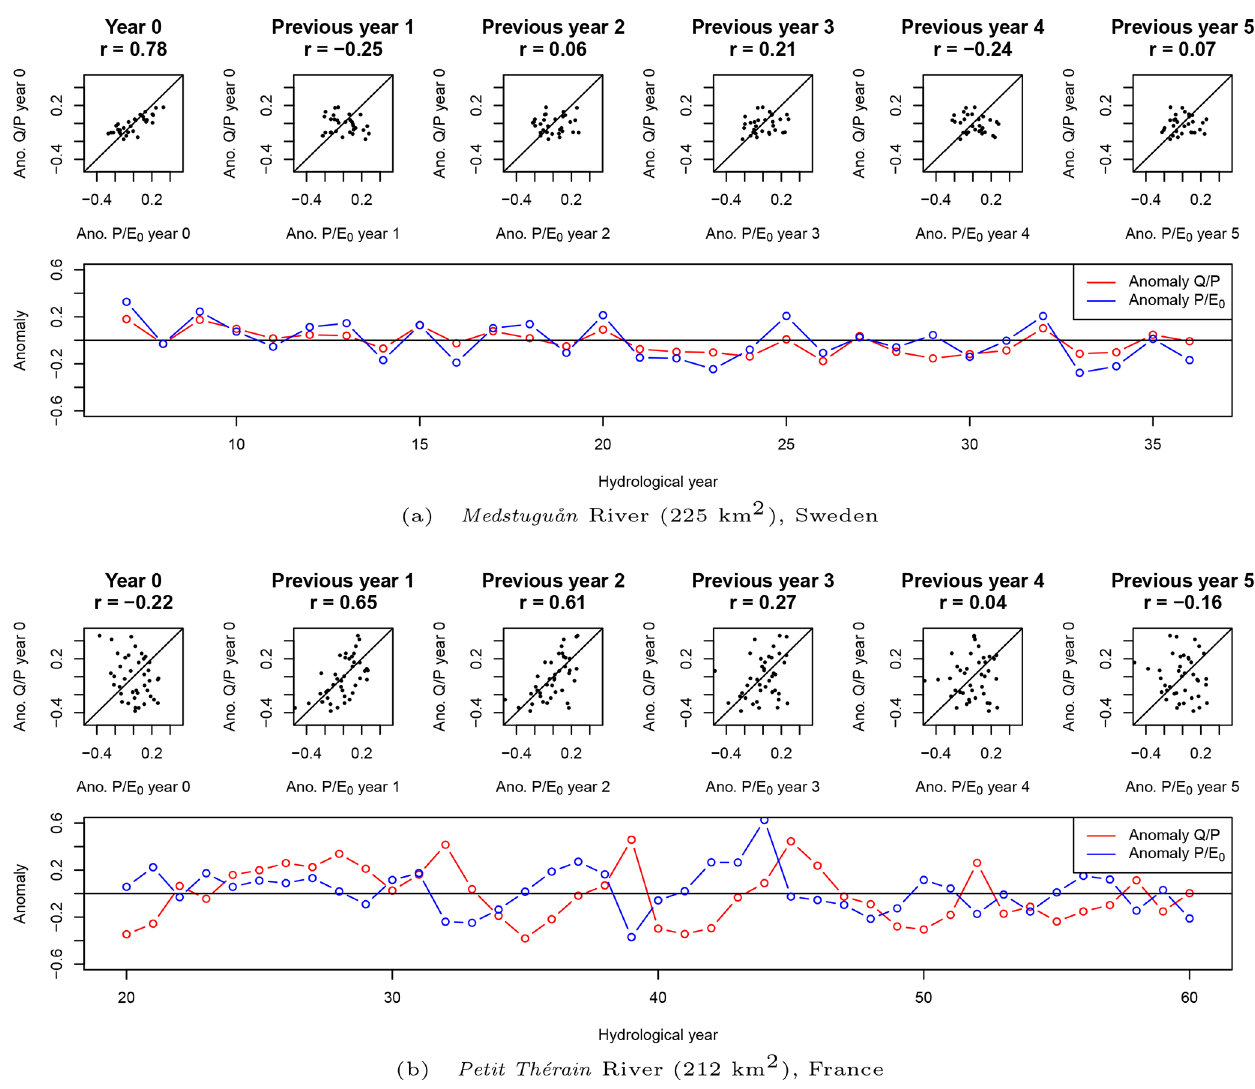
Figure 1. Elasticity analysis example of two catchments. No multi-year memory is detected on this Swedish catchment: a climatic anomaly P/E 0 is directly affecting Q/P of the same year but not later. In opposition, a multi-year memory is detected on this French catchment: the effect of a climatic anomaly P/E 0 on the hydrology ( Q/P ) only starts after 1 year, before slowly decreasing (according to Pearson’s r correlation